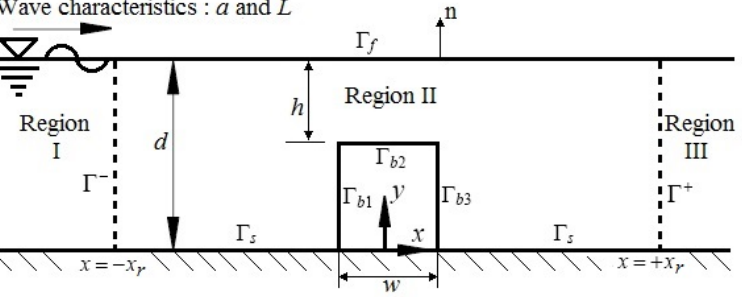
Figure 2. Problem definitions for the breakwater system.